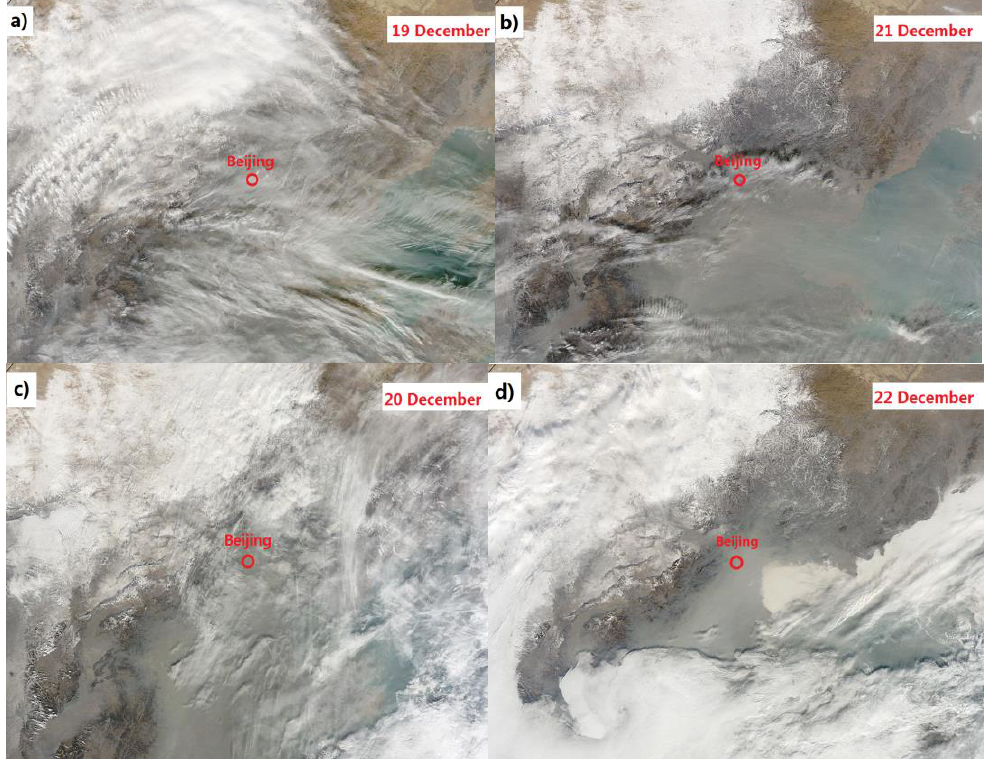
Figure 11. The ( a , b ) Aqua and ( c , d ) Terra MODIS true color images for 19–22 December 2015.